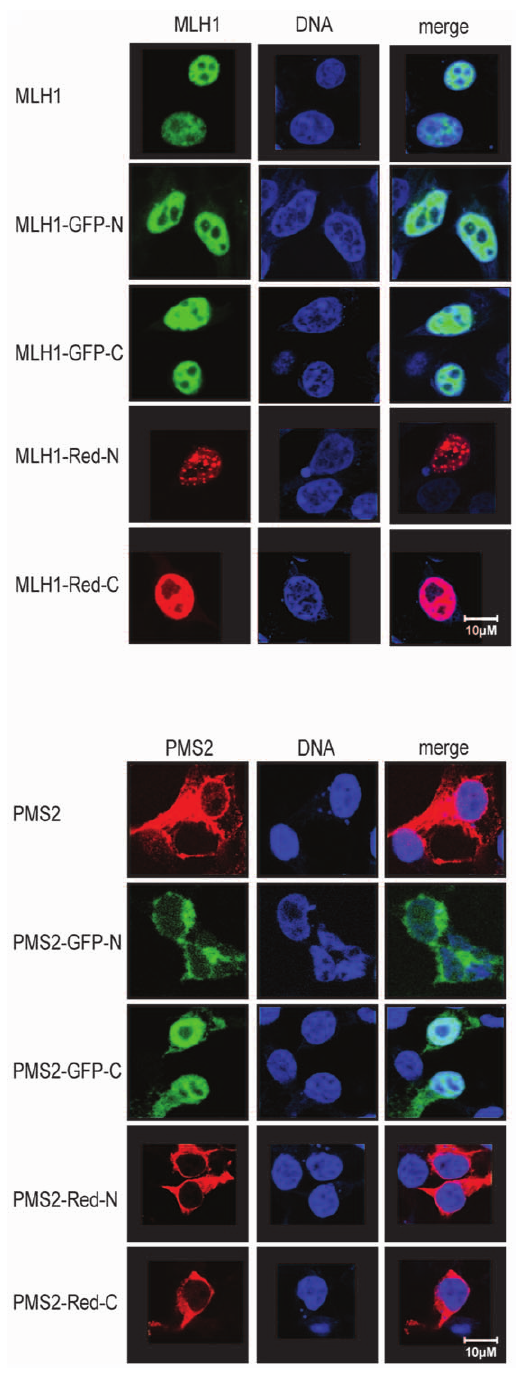
Figure 3. Subcellular localization of single expressed MLH1 and PMS2 variants. HEK293T cells were transfected with different MLH1 or PMS2 constructs as indicated to the left. MLH1 and PMS2 were visualized after 48 h using confocal laser microscopy. Nuclei were counterstained with TO-PRO-3 (middle column) after fixation and resulting overlay is shown in the right column. As a control, unlabeled MLH1 or PMS2 was transfected in parallel and visualized after 48 h using FITC-labeled goat anti-mouse IgG Alexa Fluor 488 for MLH1 detection (shown in green; left column) whereas unlabeled PMS2 was detected with the FITC-labeled goat anti-rabbit IgG Alexa Fluor 555. All used labeled MLH1 and PMS2 constructs showed the same cellular localization as the unlabeled form, with the exception of PMS2-GFP-C which was detected in the nucleus although all other constructs were located in the cytoplasm.